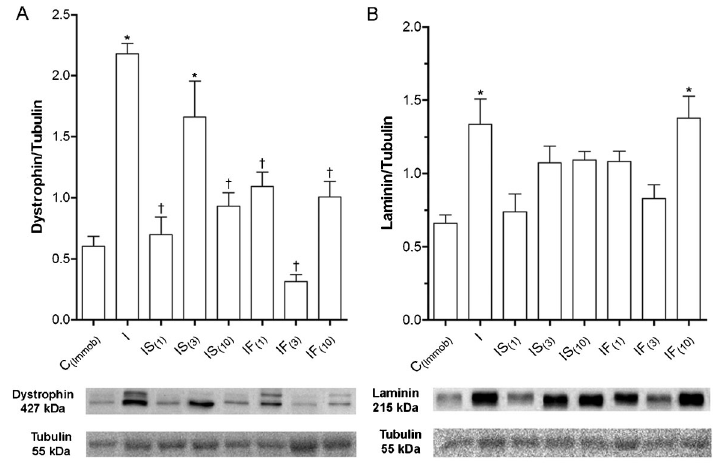
Figure 4. Western blot analysis for dystrophin ( A ) and laminin ( B ) in the soleus muscle of animals in the groups analyzed. See Figure 1 legend for explanation of abbreviations. *P , 0.05 compared to C (Immob) ; { P , 0.05 compared to I (Student t